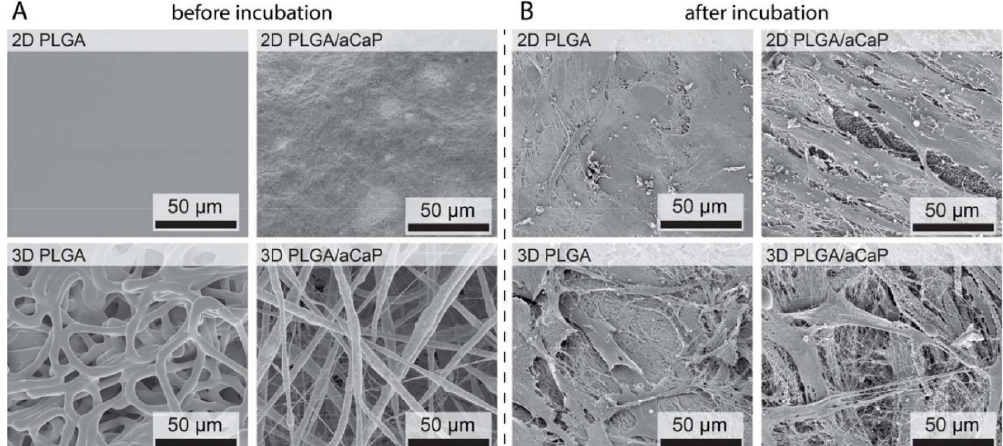
Figure 2. The 2D and 3D scaffolds of PLGA and PLGA/aCaP, shown without cells in ( A ), were seeded with adipose-derived stem cells for 14 days, shown in ( B ). The interaction between cells and material seems to be enhanced on scaffolds containing calcium phosphate compounds because of aCaP nanoparticles and newly formed hydroxyapatite (Hap), while biofilm formation is observed on pristine PLGA rather than adhesion of the cells as found for PLGA/aCaP.